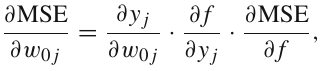
Fig. 14 Solution for the case of the AND gate. The x axis represents the first bit of the AND gate whereas the y axis the second bit. Thus, the yellow regions defines the region where the bolean product is 0 whereas the blue region represents the region where the bolean product is 1. The sharp changes between the region 0 and 1 is a consequence of the neuron